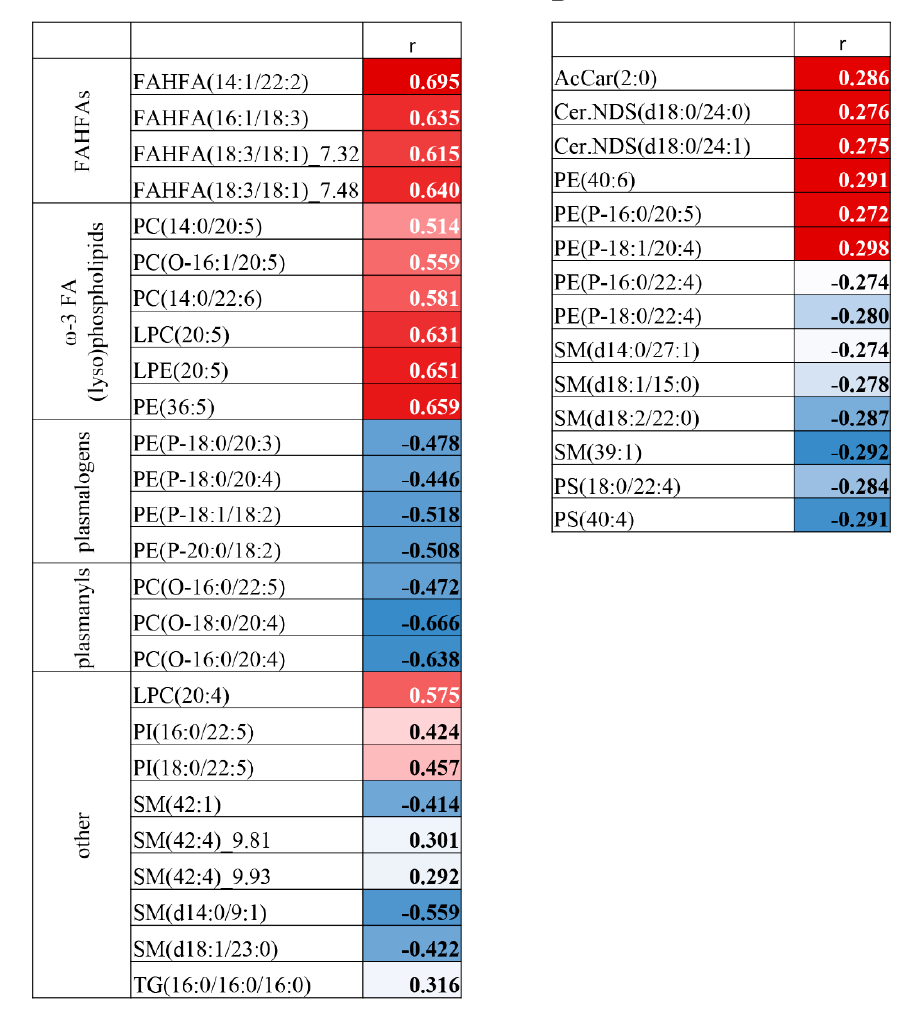
Figure 5. Correlation between MDA concentration and VIP lipids in plasma ( A ) and erythrocytes ( B ). The correlation was calculated as Spearman coefficient; only statistically significant values are shown. Blue color indicates negative and red color positive correlation. MDA, malondialdehyde; PUFA, polyunsaturated fatty acids; FAHFAs, fatty acyl-esters of hydroxy-fatty acids.